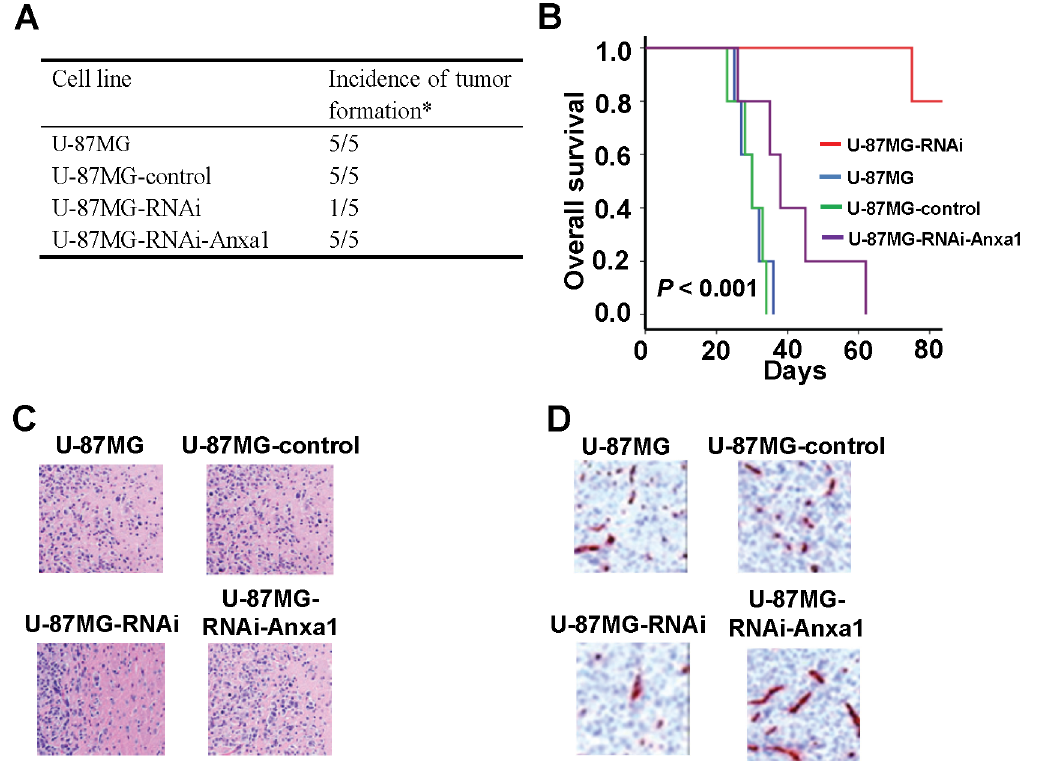
Figure 5. Effect of FoxM1/Anxa1 expression on glioma growth in the brains of nude mice. A, Glioma cells (1 6 10 6 ) were implanted intracranially into nude mice. Mice were euthanized when they were moribund or on day 90. * Incidence: number of mice with tumor/number of mice injected. B, Kaplan-Meier estimates of overall survival time in nude injected with glioma cells (P , 0.001). C, Morphologic alteration of the xenograft tumors was analyzed by H&E. D, CD31expression level in xenograft tumors was analyzed by